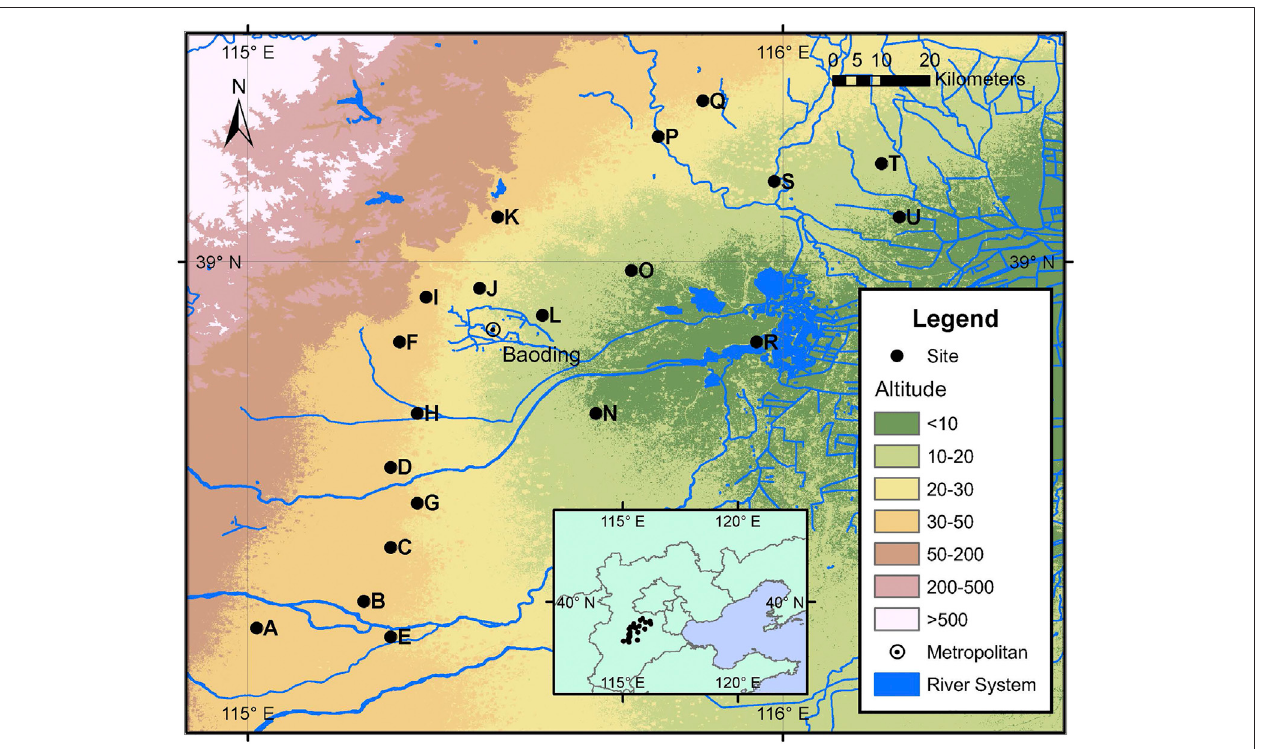
FIGURE 1 | Location of all sites in the study